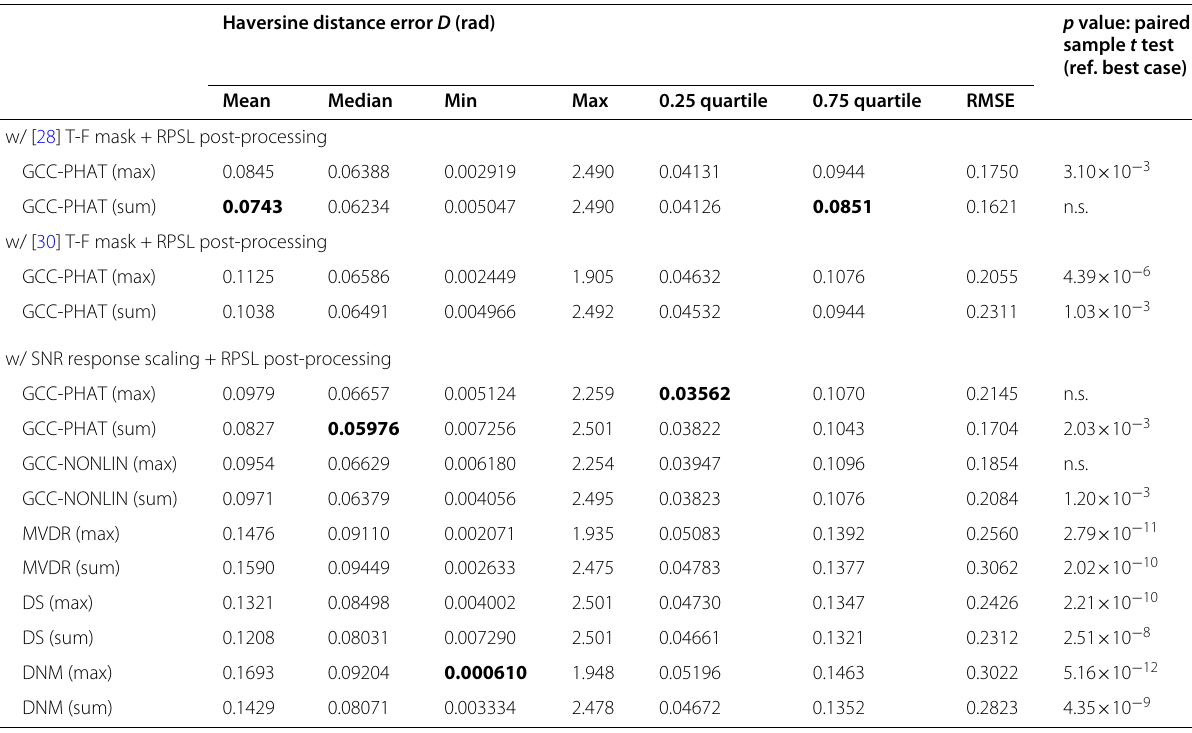
Table 4 Haversine distance error performance comparison (task 2—flying UAV, broadband sound source) ( Continued